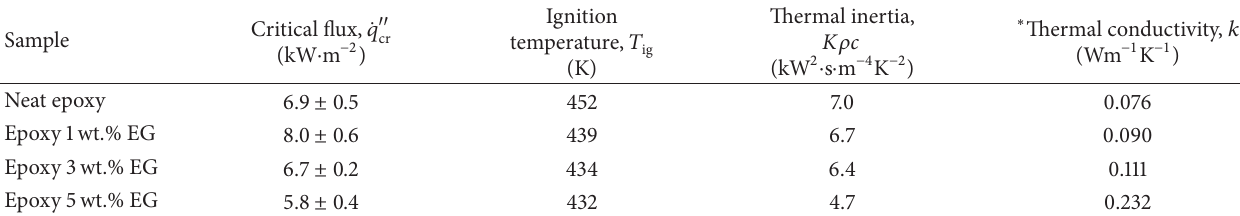
Table 4: Ignition characteristics of epoxy-expandable graphite composite samples.